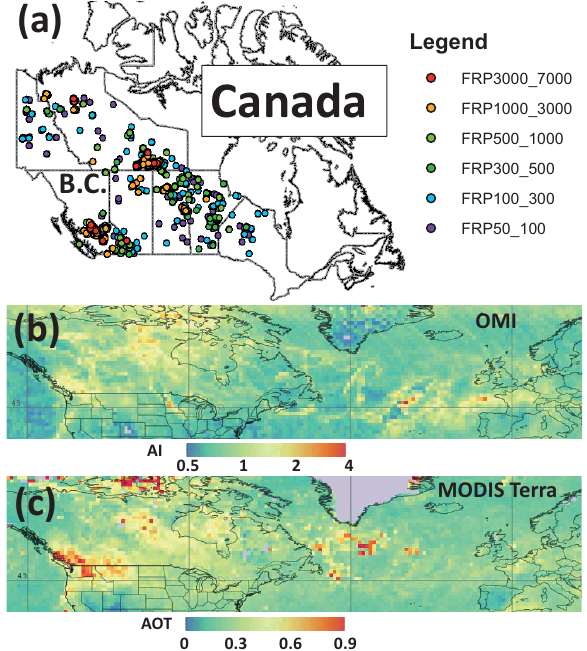
Figure 1. (a) Fires detected with MODIS aboard the Terra and Aqua satellites over Canada in the period from 1 to 31 August 2017. The six color-coded classes of FRP (numbers define the range of values in MW) indicate different fire strengths (intensity of biomass burn- ing). Intense wildfires accumulated in the southern part of British Columbia (B.C.). (b) August 2017 mean AI (aerosol index, OMI) at 354nm, and (c) August 2017 mean 550nm AOT (MODIS) (Acker and Leptoukh,